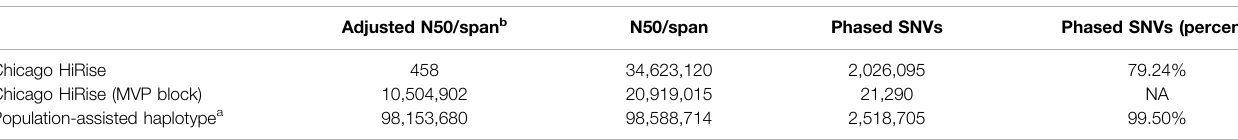
TABLE 2 | Haplotype block statistics with diverse sequencing protocols for